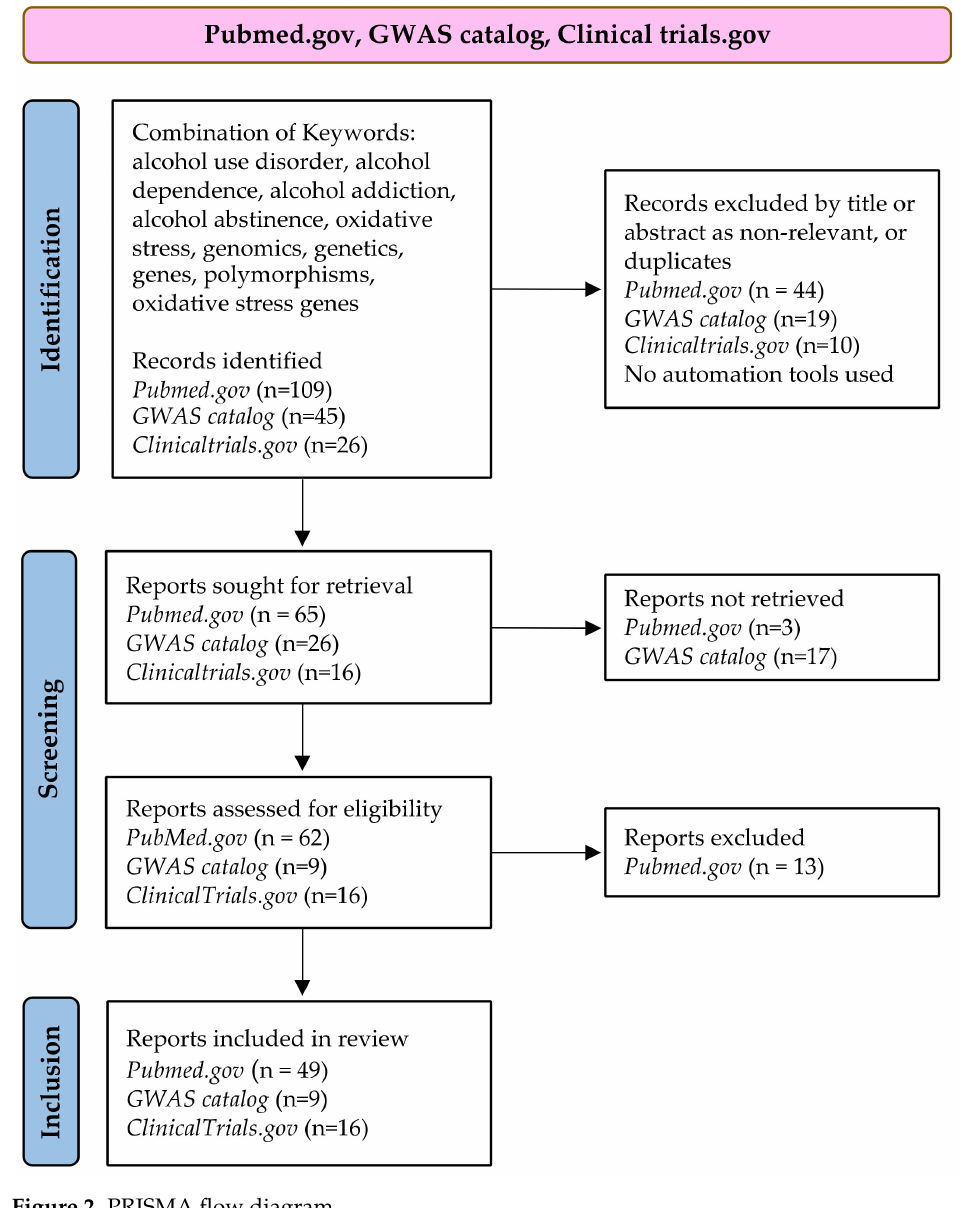
Figure 2. PRISMA flow